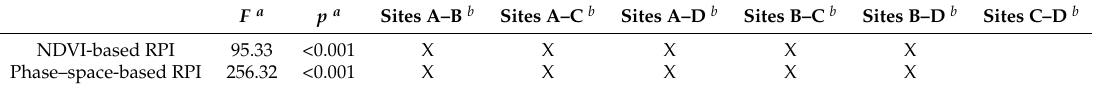
Figure 9. Statistical box charts of ( a ) the NDVI-based RPI and ( b ) the phase–space-based RPI in the four experimental sites. Central lines represent the medians, boxes represent mean ± standard deviation, and the whiskers represent the minimum and maximum values. Table 5. Sensitivity of the NDVI- and phase–space-based RPI to heavy metal stress